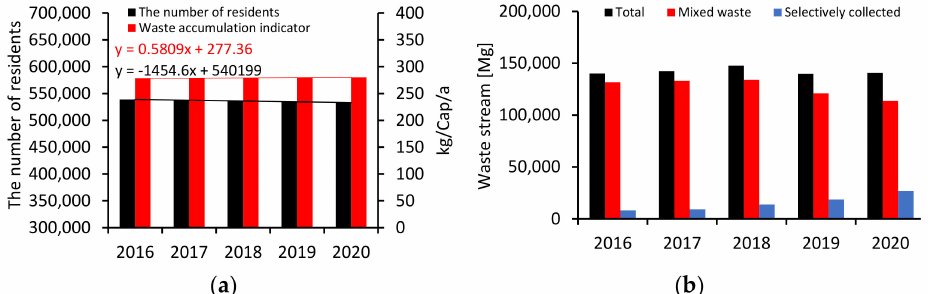
Figure 11. Change in the amount of municipal waste collected, demographic factors and the level of selective collection in the 37 municipalities served by the Municipal Waste Management Plant in Olsztyn, Poland; ( a ) demographic factors; ( b ) selective collection of